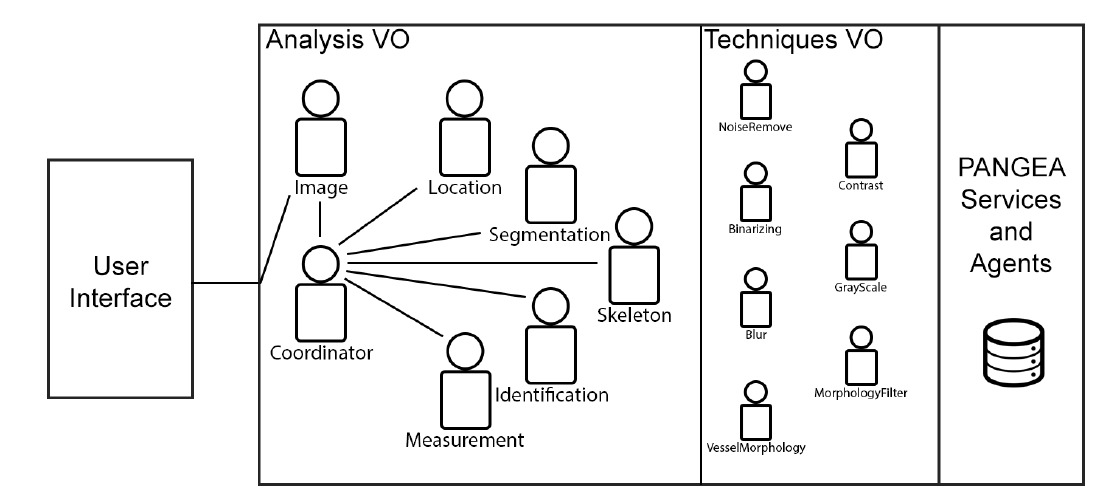
Figure 1. Virtual Organizations (VO) and agents’